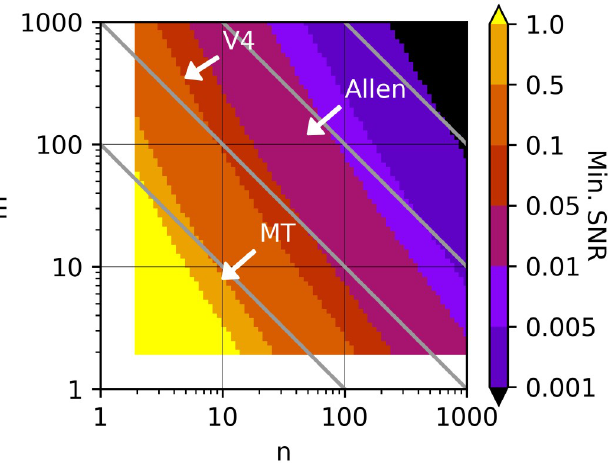
Fig 13. The minimal SNR needed to reliably detect tuning as a function of m , the number of unique stimuli, and n , the number of repeats of each stimulus. White arrows indicate the approximate location in ( m , n ) corresponding to the datasets used in Fig 12. Gray diagonal lines indicate constant number of total trials ( n × m